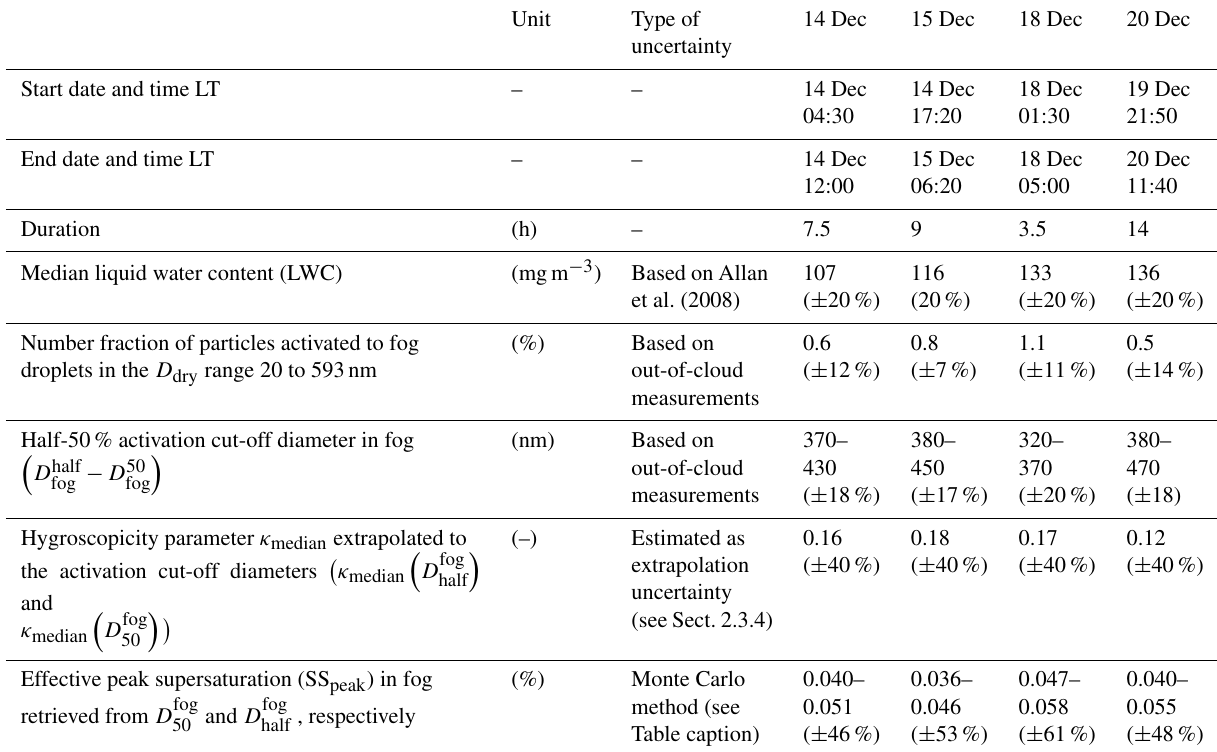
or D fog and κ median half 50